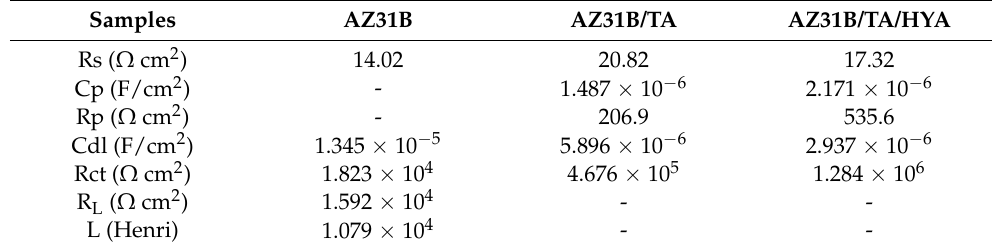
Table 6. EIS measurement results on samples AZ31B, AZ31B/TA, and AZ31B/TA/HYA.